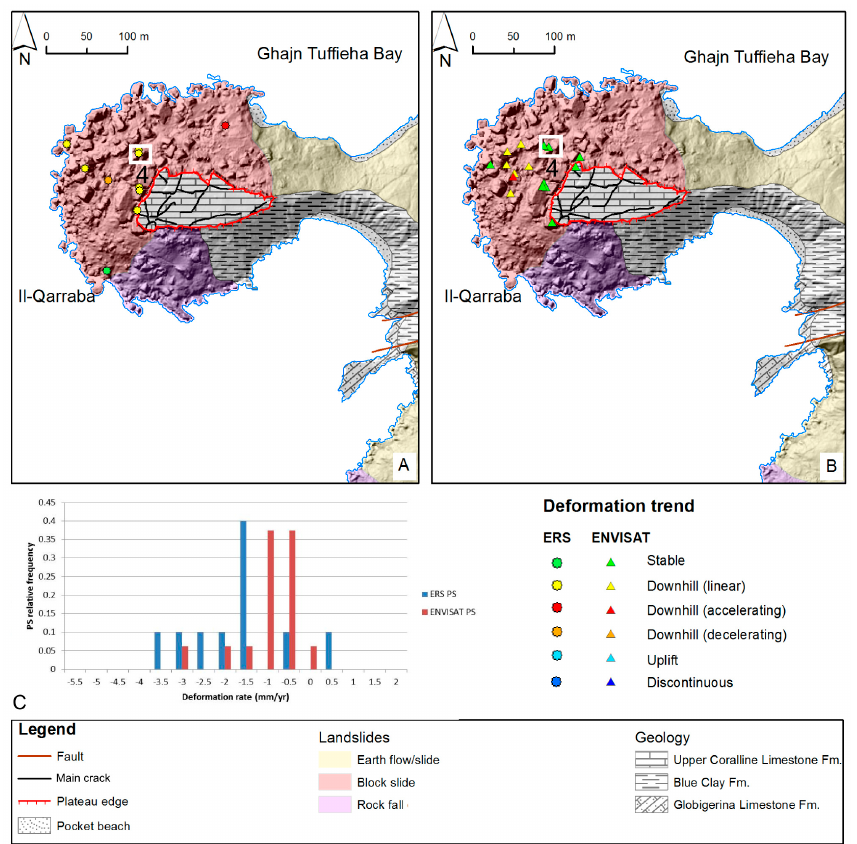
Figure 15. Il-Qarraba landslide map and distribution of the PS, color coded according to the trend classes defined in Figure 4: ( A ) ERS satellite PS deformation trend; ( B ) ENVISAT satellite PS deformation trend; ( C ) Histogram showing the relative frequency of occurrence in each class of movement rate. The white box on the map locates the PS whose time series are reported in Figure 6d.